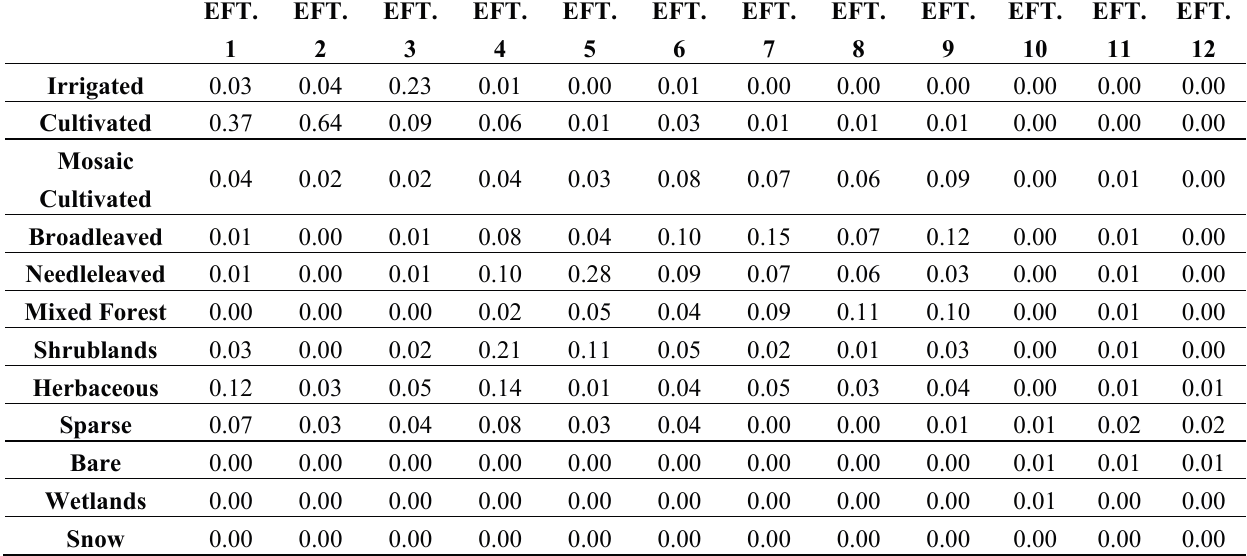
Table B. Minnick’s coefficient (Cm) to show the degree of overlap between the land cover dataset and the EFTs.